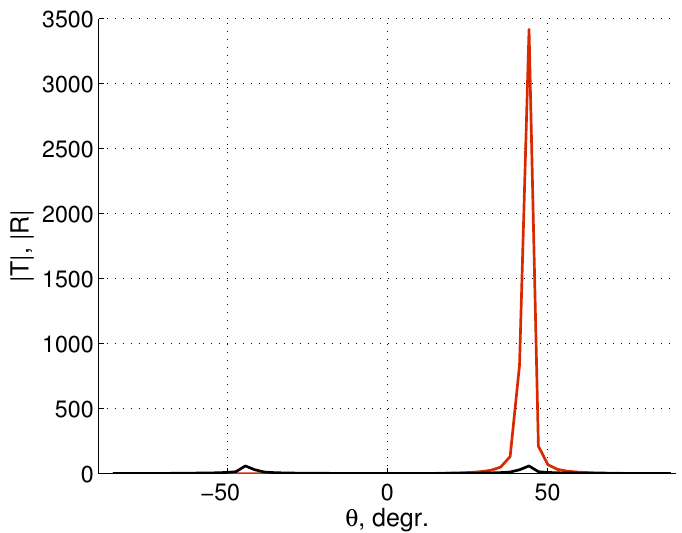
Figure 7. Transmission (red) and reflection (black) coefficients.